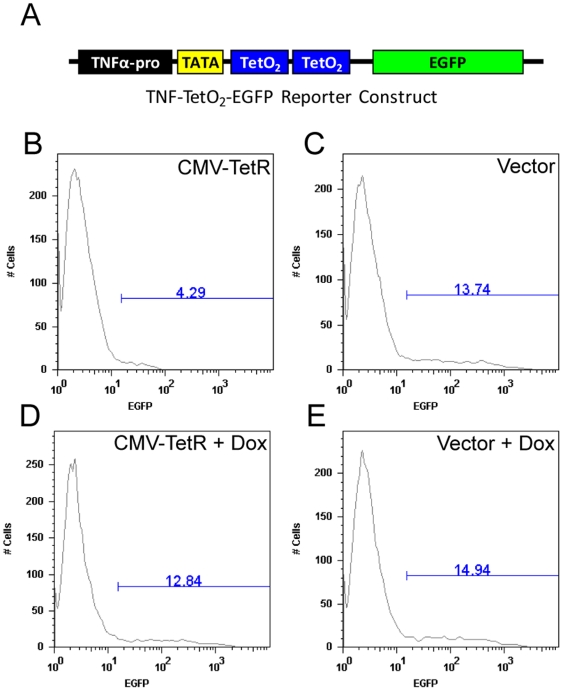
Tet-repressor can reversible inhibit basal TNF-α promoter activity.(A) Schematic diagram of the TNF-TetO2-EGFP reporter construct. Two Tet operator binding sites (TetO2) were cloned 10 bp downstream of the TNF-α promoter TATA box. (B–E) HEK-293T cells were cotransfected with TNF-TetO2-EGFP reporter construct and (B and D) pcDNA6/TR which encodes the Tet-repressor driven by the CMV promoter (CMV-TetR) or (C and E) pcDNA3.1 vector control (Vector) in the presence of doxycycline (DOX) or vehicle. EGFP expression was monitored 48 hours later by flow cytometry.